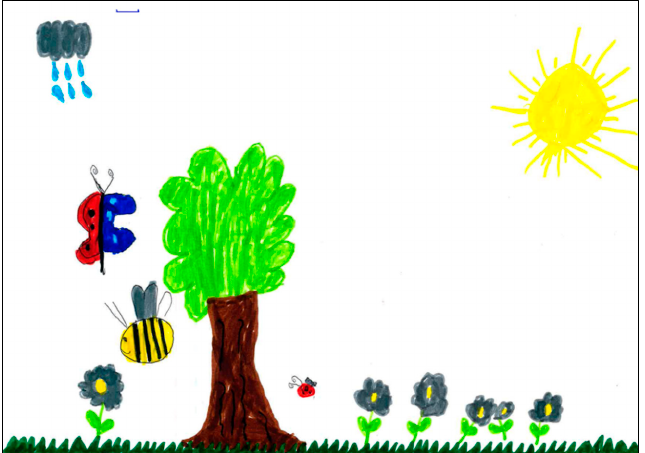
Figure A1. The drawings on the topic of plant that a 5 year old child completed in 2019.